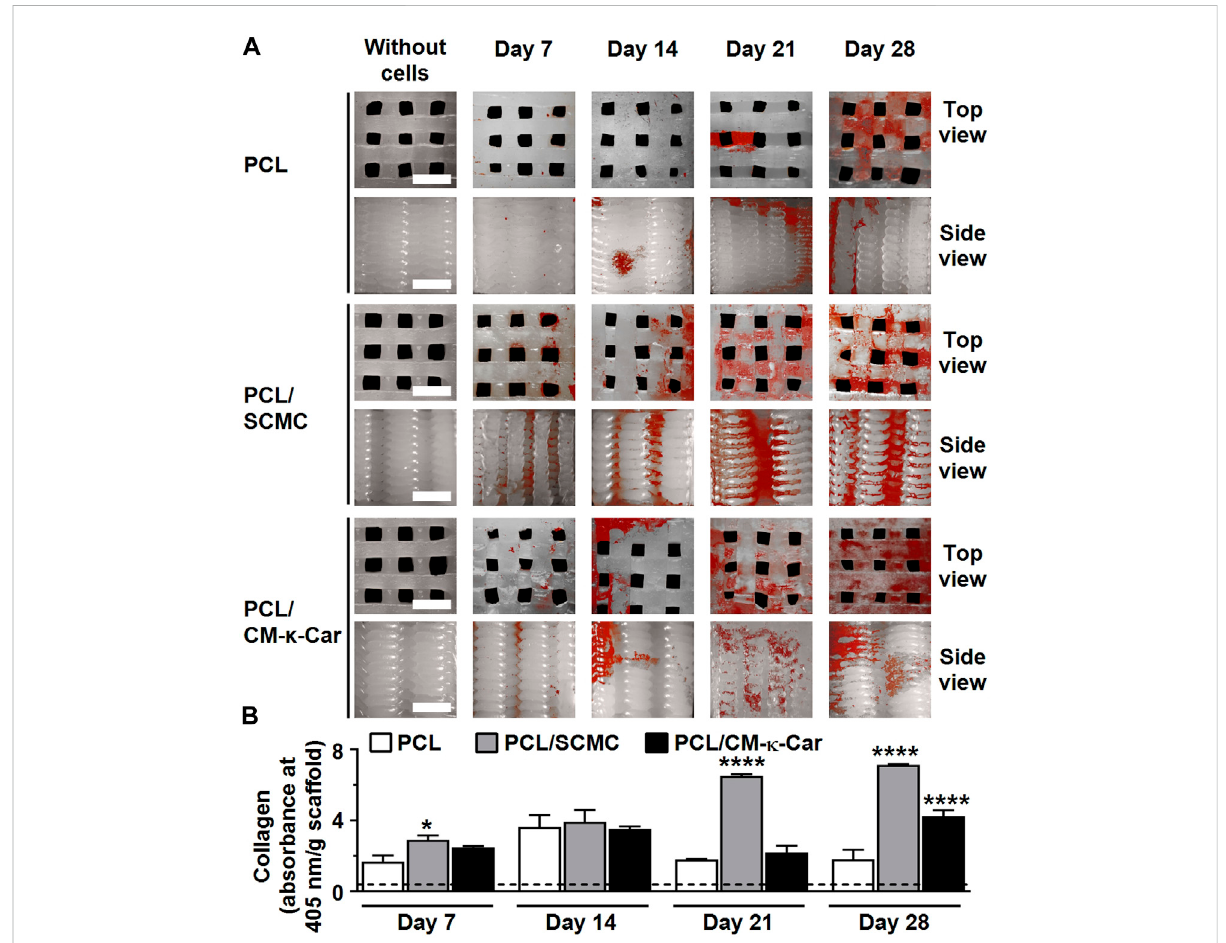
FIGURE 8 Effect of 3D-printed PCL scaffold surface-functionalization by SCMC or CM- κ -Car on collagen production by MC3T3-E1 pre-osteoblasts after 7, 14, 21, and 28 days. (A) Collagen staining (red). Collagenous matrix production, visualized by picrosirius red staining. Scale bar: 1.5 mm. (B) Quanti fi cation of collagen production. Values are mean ± SD ( n = 3). *Signi fi cantlydifferentfrom control 3D-printed PCL scaffolds, p < 0.05, **** p < 0.0001. PCL, poly- ε -caprolactone; SCMC, sulfated carboxymethyl cellulose; CM- l -Car, carboxymethyl l